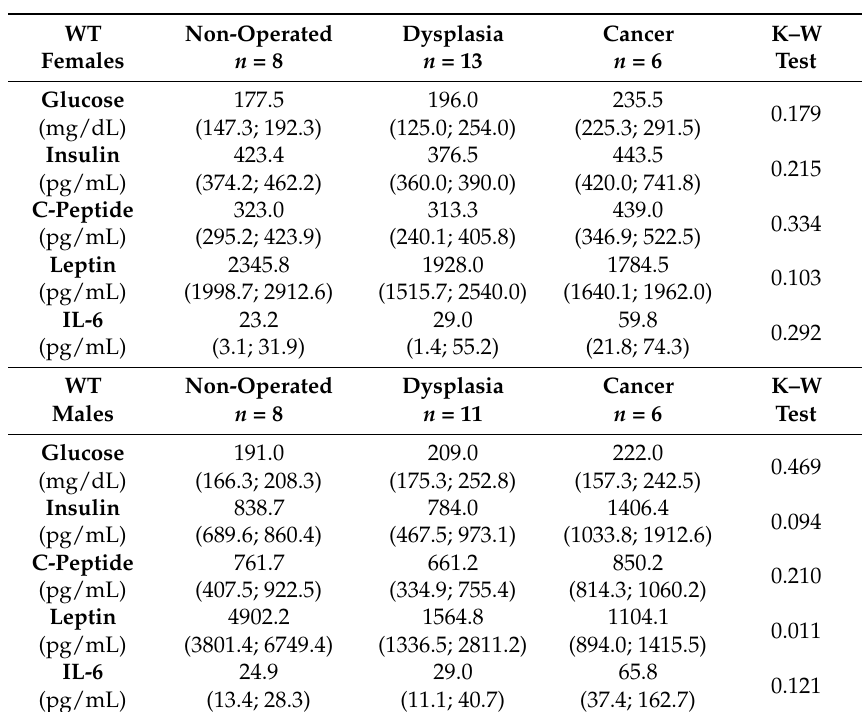
Table 3. Serum metabolic parameters in operated WT mice. Data were expressed as Median (Q1; Q3). Data obtained in operated mice affected by dysplasia or cancer were compared to strain-, sex-, and age-matched non-operated animals (43 weeks). K–W test indicates the Kruskal-Wallis test result used for multiple comparisons among the three groups of mice. A p -value lower than 0.05 was considered statistically